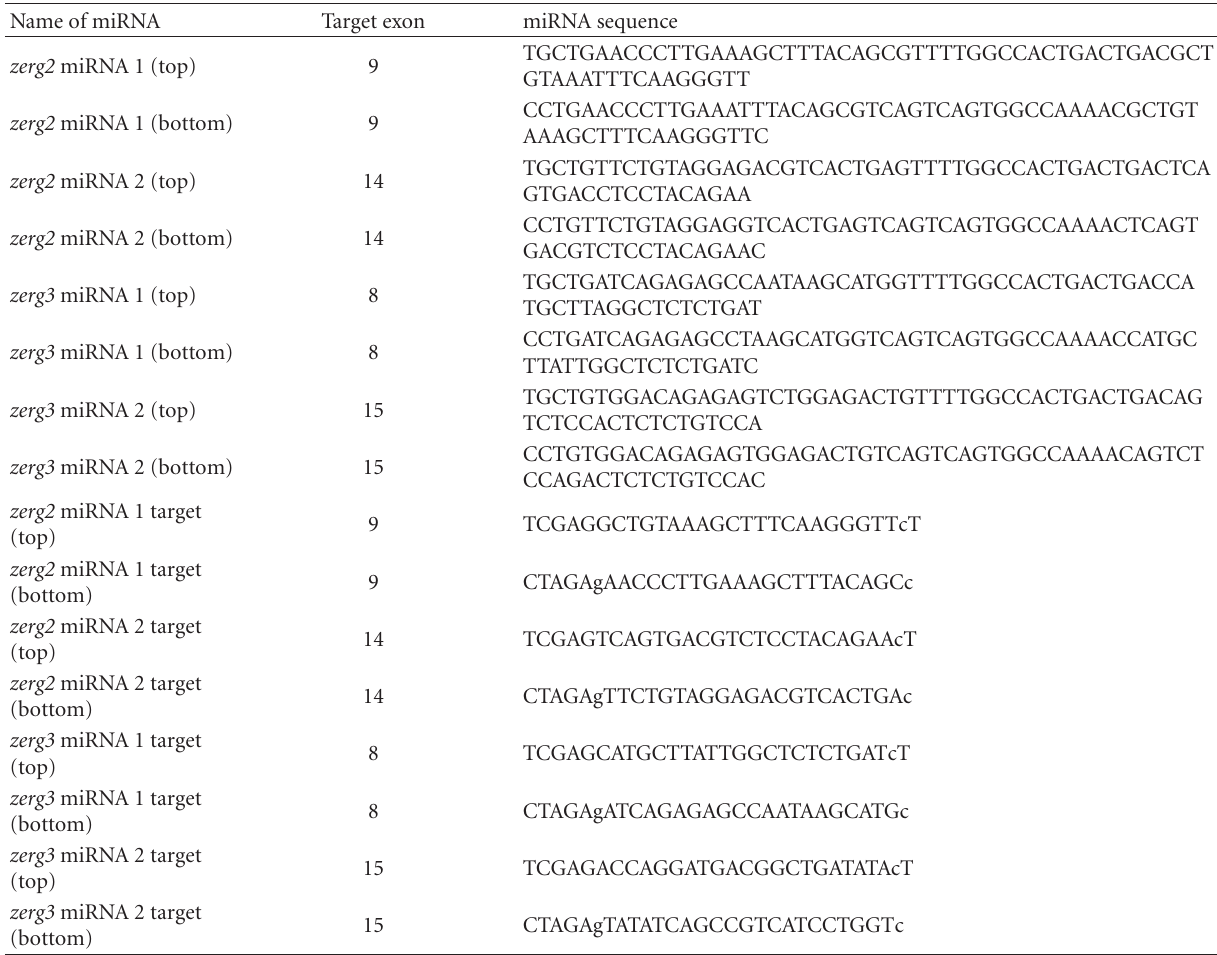
Table 1: Sequences of miRNAs and their respective